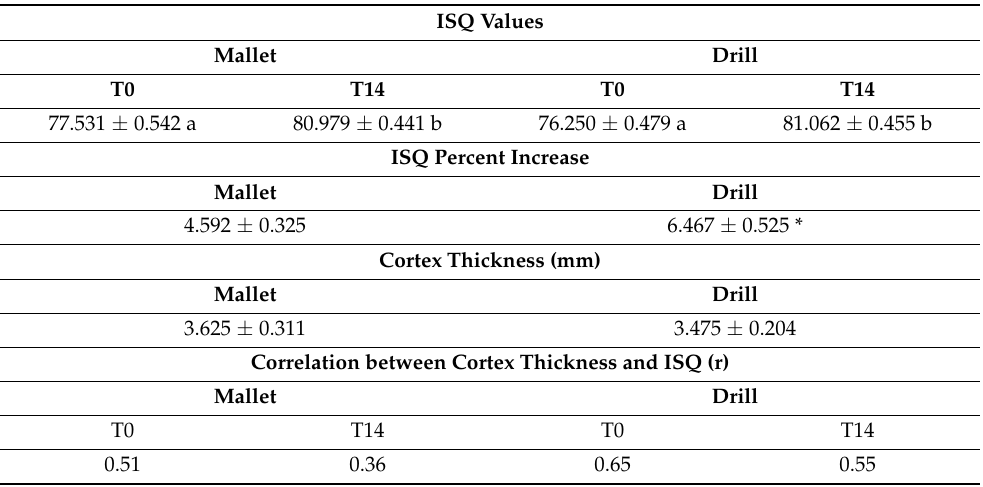
Table 1. Clinical data representing the values of the Implant Stability Quotient (ISQ), the cortex thickness, and their correlation. ISQ Values Mallet Drill